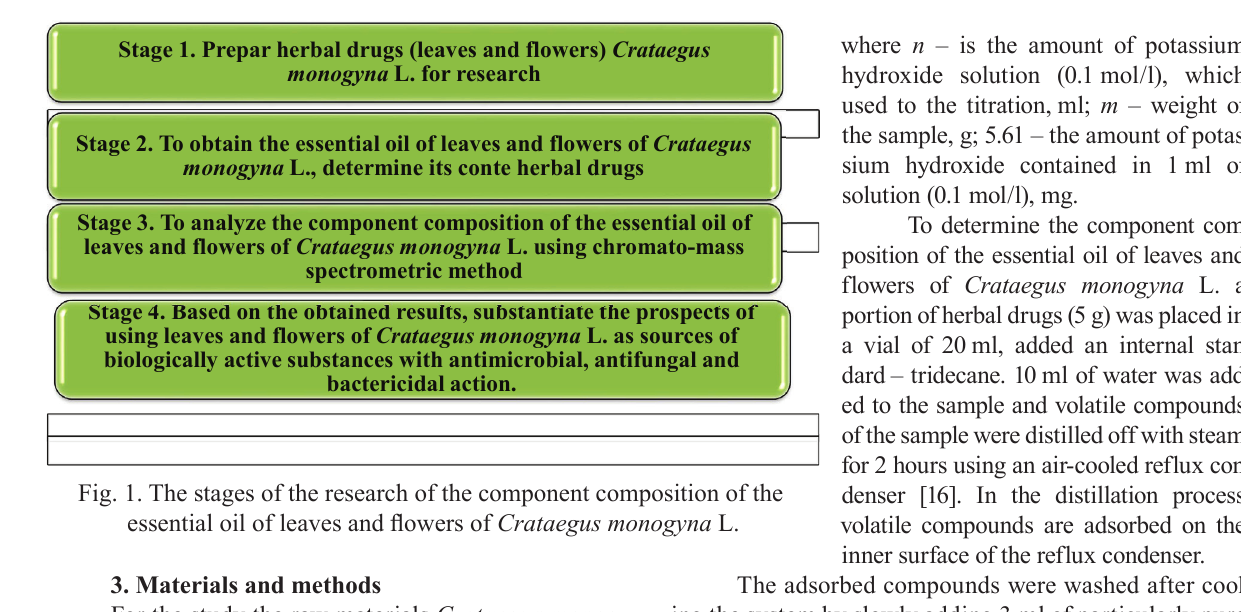
Stage 1. Prepar herbal drugs (leaves and flowers) Crataegus monogyna L. for research Stage 2. To obtain the essential oil of leaves and flowers of Crataegus monogyna L., determine its conte herbal drugs Stage 3. To analyze the component composition of the essential oil of leaves and flowers of Crataegus monogyna L. using chromato-mass spectrometric Stage 4. Based on the obtained results, substantiate the prospects of using leaves and flowers of Crataegus monogyna L. as sources of biologically active substances with antimicrobial, antifungal and bactericidal action.